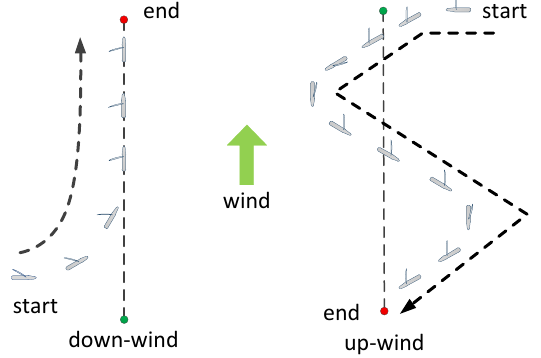
Figure 5. Sailing in up-wind and down-wind.